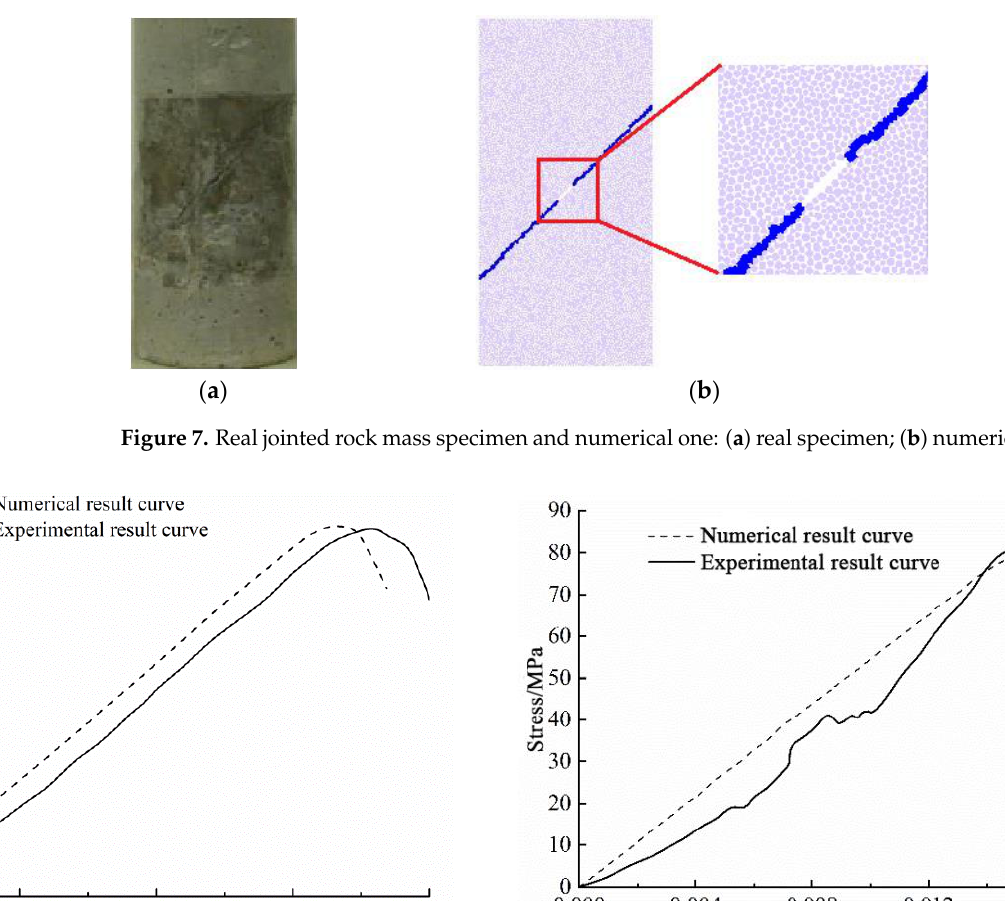
Figure 8. Stress – strain curves of real tests and numerical results: ( a ) sandstone; ( b ) granite. Table 4. Microscopic parameters of numerical models.